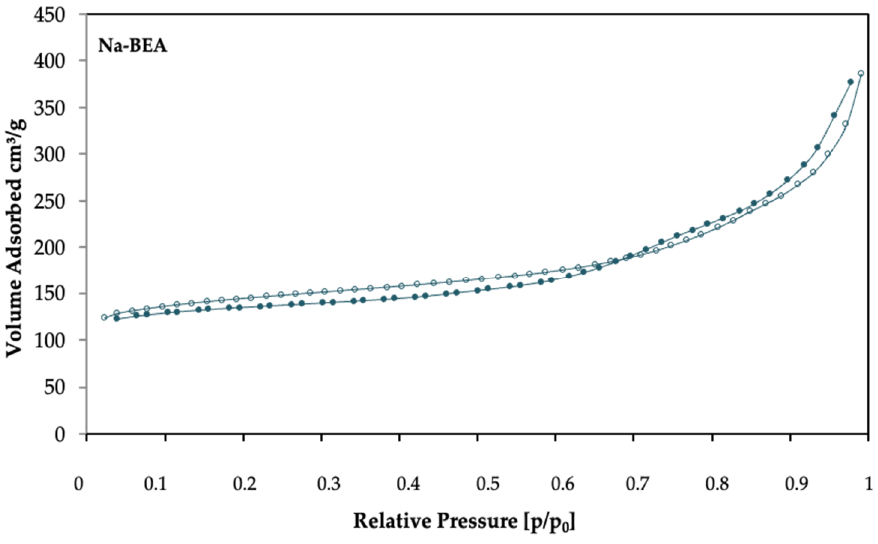
Figure 3. Nitrogen adsorption and desorption isotherms for synthetic Na-BEA zeolite.